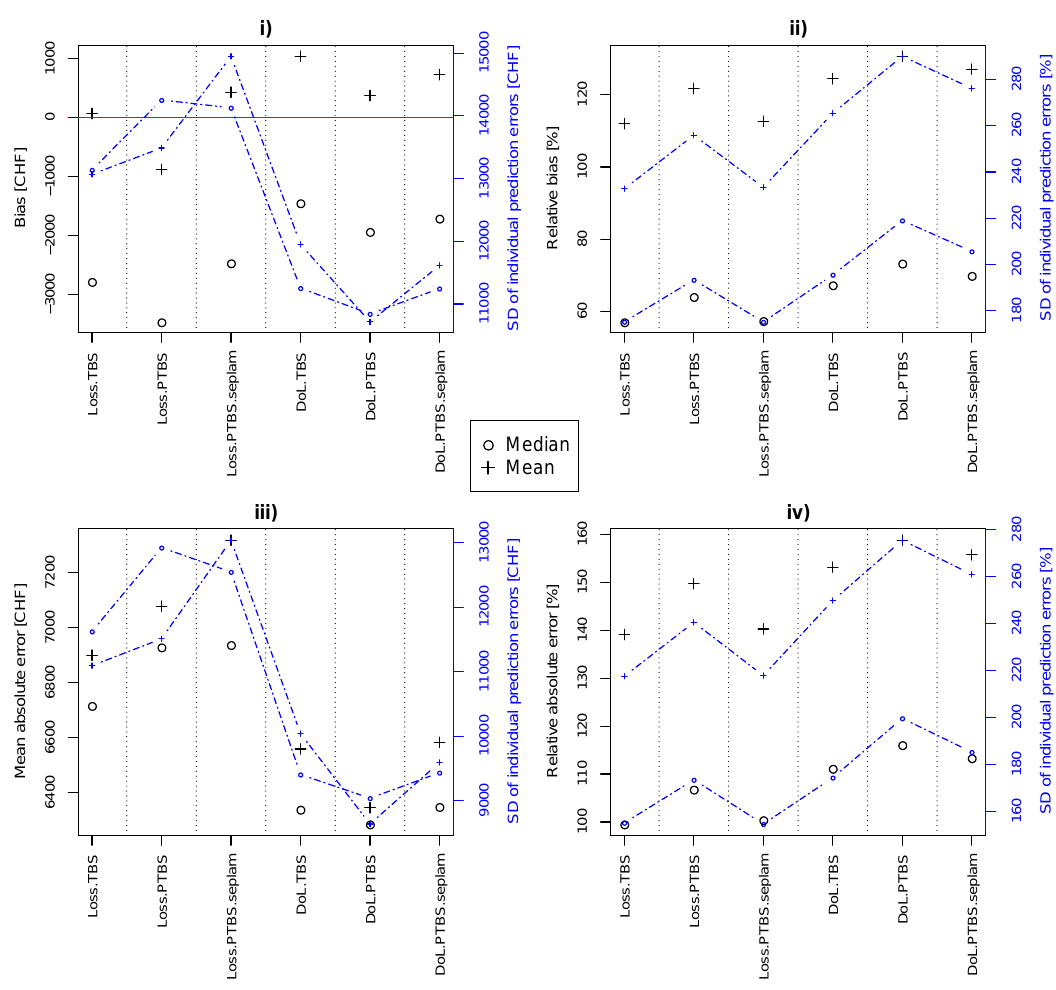
Figure 4. Cross-validation results for the model combinations based on leave-one-out cross-validation. ◦ : Aggregated prediction error with median prediction; +: Aggregated prediction error with mean prediction. The blue line indicates the standard deviation of the individual prediction